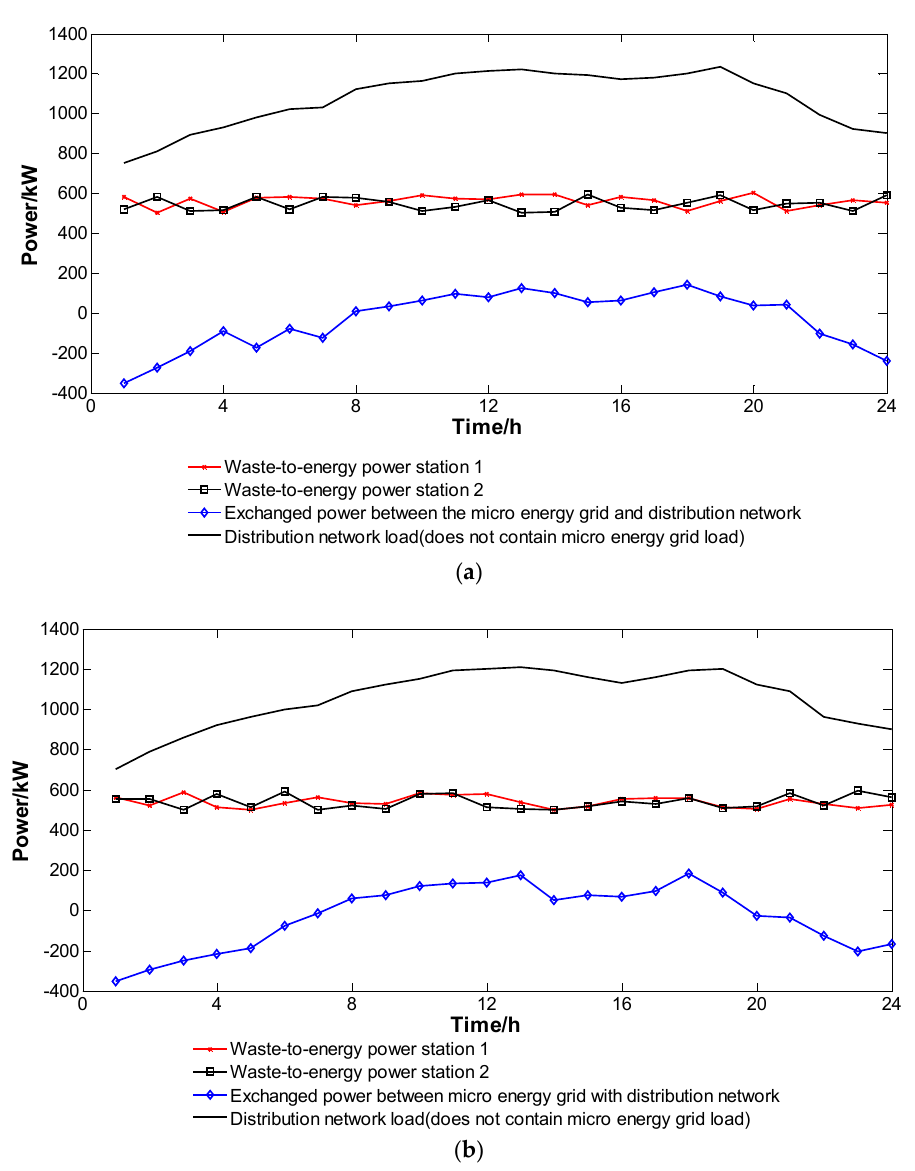
Figure 11. Optimal dispatching schemes of the distribution network comprising the micro energy grid on a typical day in the winter ( a ), and in the summer ( b ).